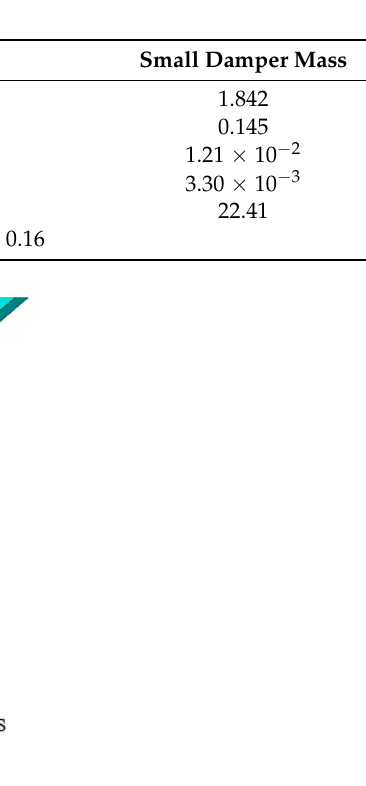
Figure 23. Detail of FE model of FRSD damper. Table 2. Structure parameters of